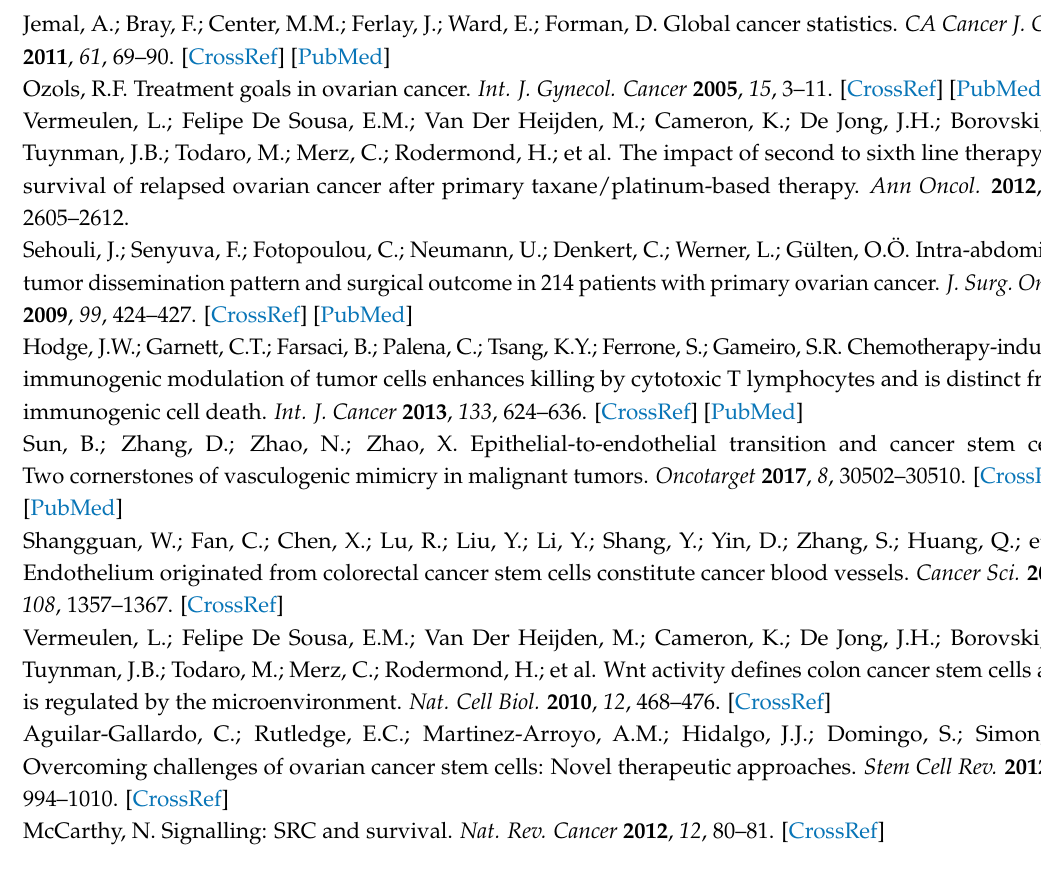
Figure S1: Effect of paclitaxel on the viability of ovarian cancer cell lines measured by MTT assay, Figure S2: Exposure of the TOV21G cells to paclitaxel enhances phosphorylation of Src in a time dependent manner, Figure S3: Effect of Dasatinib on the viability of ovarian cancer cell lines measured by MTT assay, Figure S4: Dasatinib inhibits paclitaxel-induced Src activation in TOV-21G cells, Figure S5: CSC-like marker expression is reduced with Dasatinib treatment, Figure S6: Single channel images relating to Figure 2 in the manuscript, Figure S7: Single channel images relating to Figure 3 in the